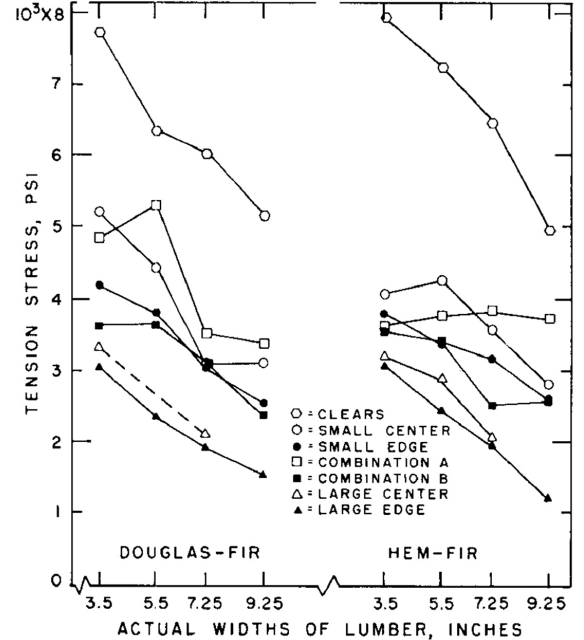
Figure 28. Plots of the tension stress values at the lower 5% exclusion limit (calculated from the data plotted in Figure 27) showing the size (width) effect more clearly. From [155]. A great deal of research has been and is being performed on the effect of specimen size on the proportional limit and fracture stresses of wood. For example, Dinwoodie